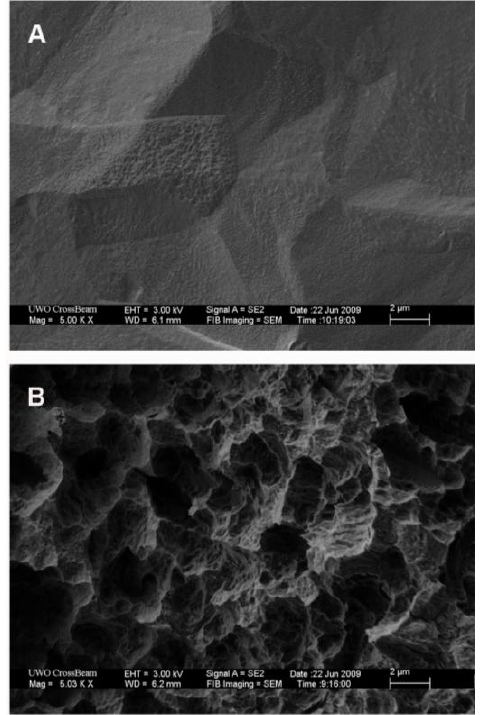
Figure 1. SEM images of the topographies employed in this investigation, ( A ) pickled titanium and ( B ) SLA ( S and-blasted, L arge grit, A